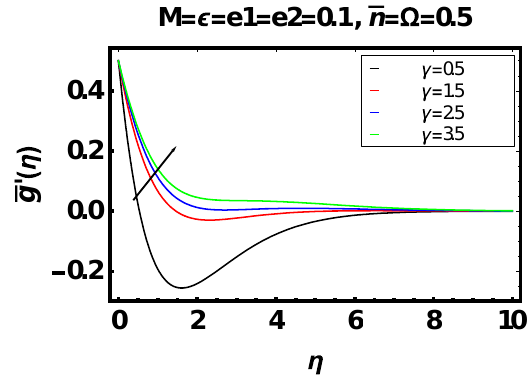
Figure 7. Velocity along y -direction for variant γ .